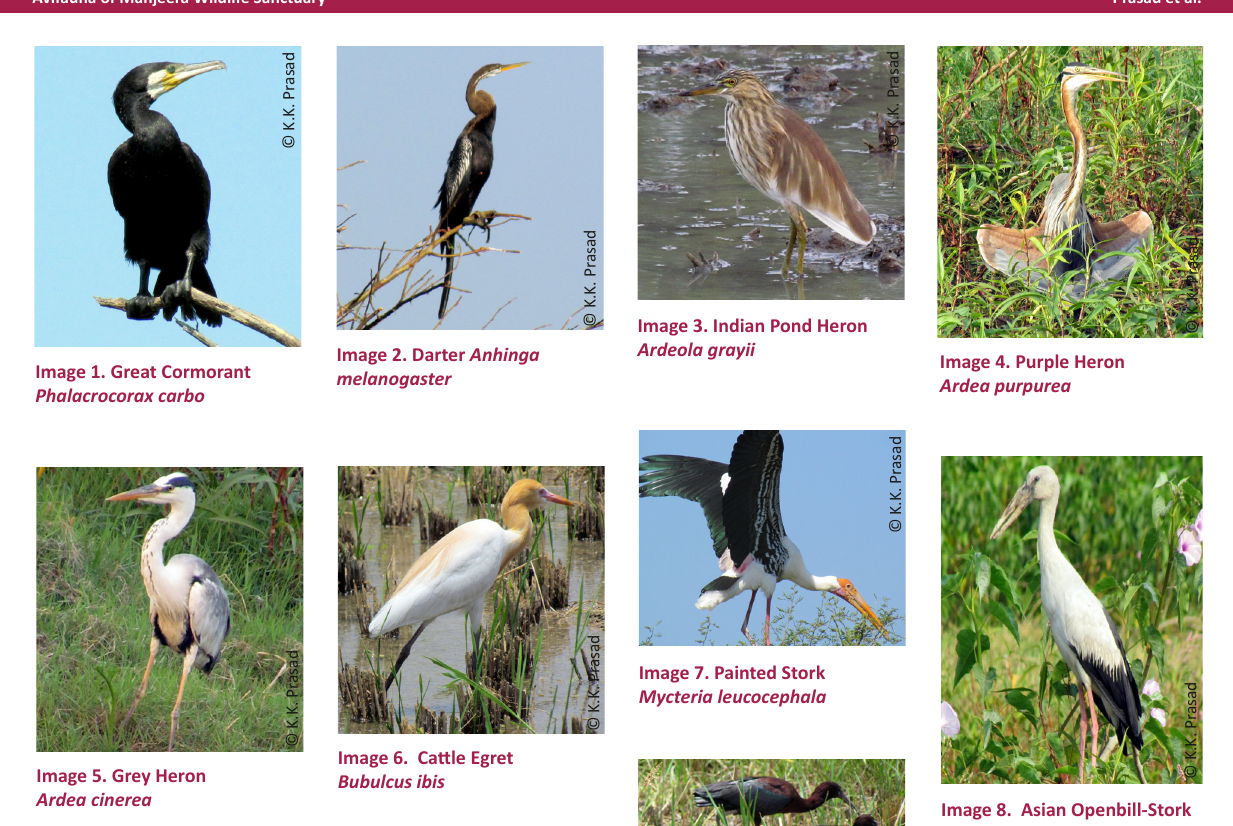
Image 7. Painted Stork Mycteria leucocephala Image 6. Cattle Egret Image 5. Grey Heron Bubulcus ibis Ardea cinerea Image 8. Asian Openbill-Stork Anastomus oscitans